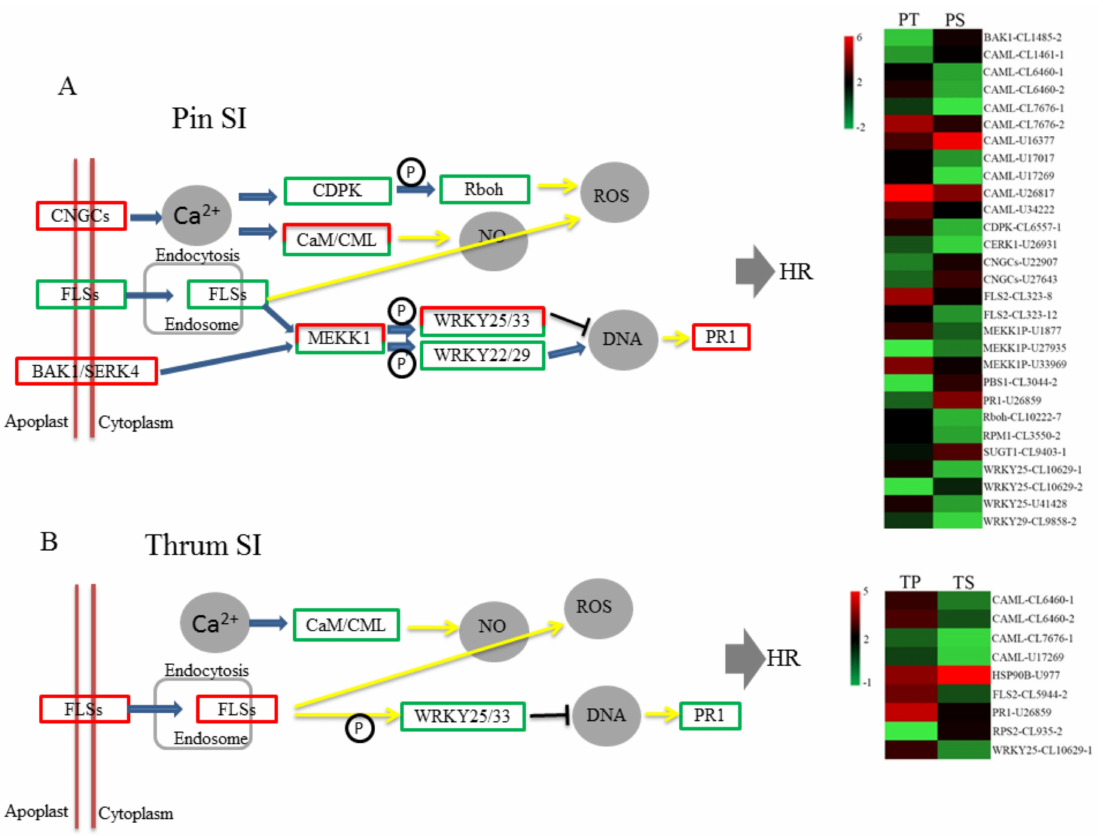
Figure 8. Analysis of DEGs enriched in plant–pathogen interaction pathways. ( A ) Simplified diagram of plant–pathogen interaction pathway of DEGs from the PS vs. PT comparison and the expression levels of the DEGs in the PT and PS pollinations. ( B ) Simplified diagram of the plant–pathogen interaction pathway of DEGs from the TS vs. TP comparison and the expression levels of the DEGs in the TP and TS pollinations. The green frame outlines indicate nodes with downregulated DEGs; red outlines indicate nodes with upregulated DEGs; green and red outlines indicate nodes with both up and downregulated DEGs. The colour scale represents the log2 values (the values of the expression levels of the